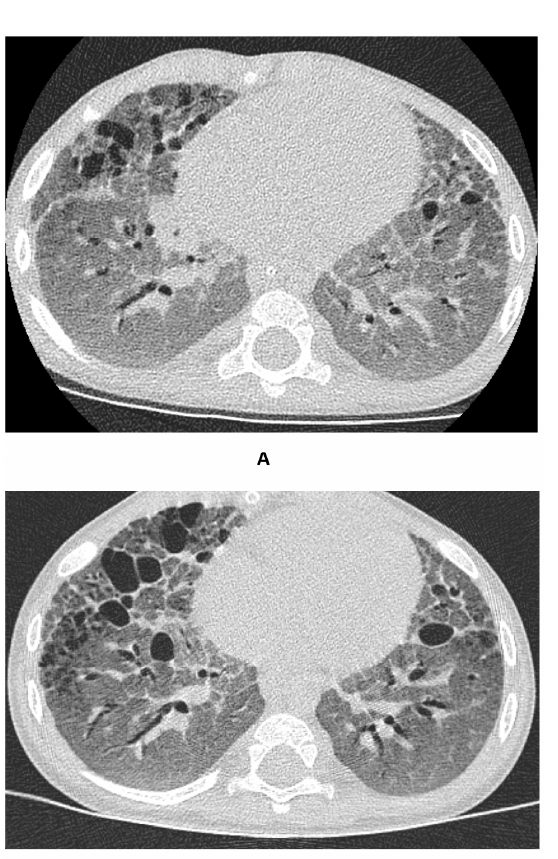
Figure 2. High-resolution CT imaging of pulmonary aspect before ( A ) and after ( B ) infusion 3 of mesenchymal stromal cells.